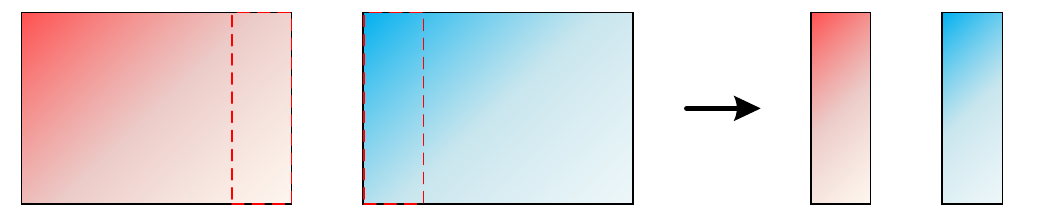
Figure 4. Overlapping area coarse extraction.